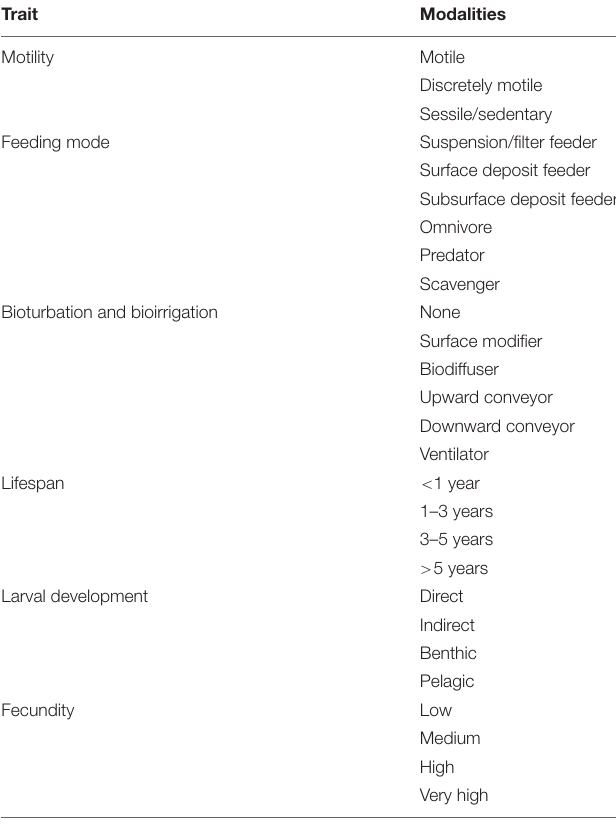
TABLE 2 | Biological traits and categories used in trait analysis. Trait